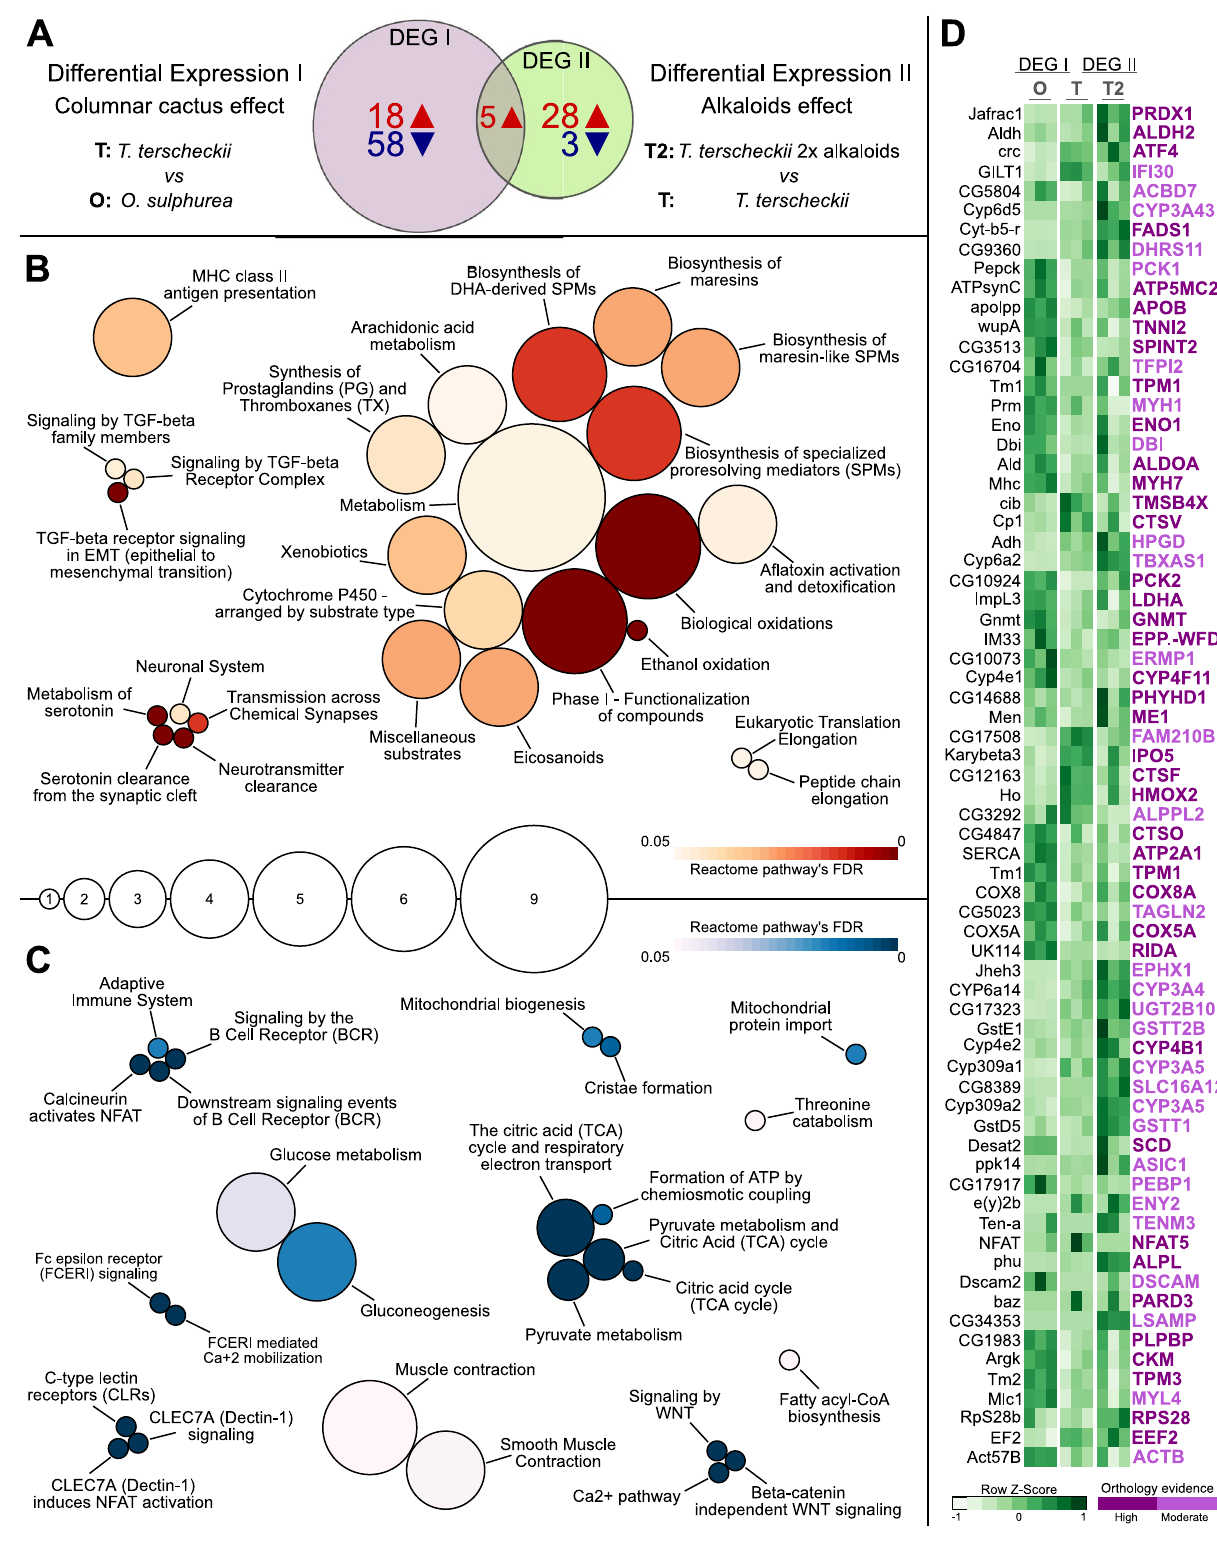
Figure 3. Results of Differentially Expressed Genes. ( A ) Number of Drosophila genes over-expressed (red) and under-expressed (blue) when exposed to the columnar cactus (DEG I) and its increased alkaloid fraction (DEG II). ( B , C ) Bubble plots depicting over-represented reactome pathways of D. melanogaster. Bubble sizes represent the number of DEGs contributing to pathway enrichment, while warm and cold colors correspond to FDR scores (< 0.05) of enriched pathways of all genes over-expressed ( B ), and under-expressed ( C ) in both DEG comparisons. ( D ) DEGs levels across treatments (O, T, T2) and orthology confidence between fly and human are depicted in the heatmap